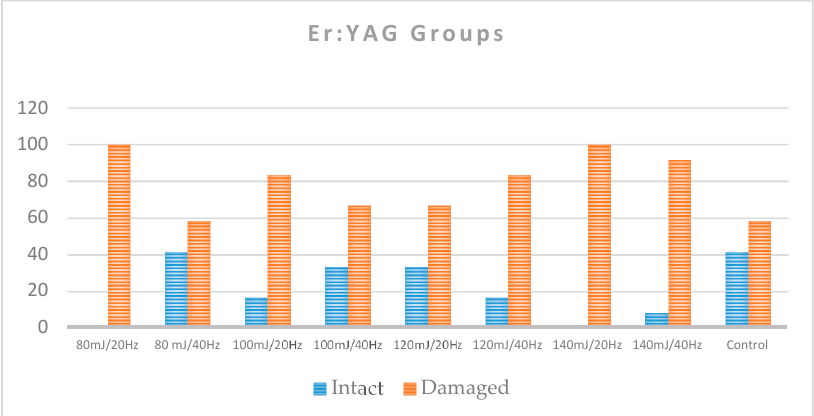
Figure 5. Shows the percentage of intact and damaged enamel in each of the Er,Cr:YSGG groups compared to the control group.